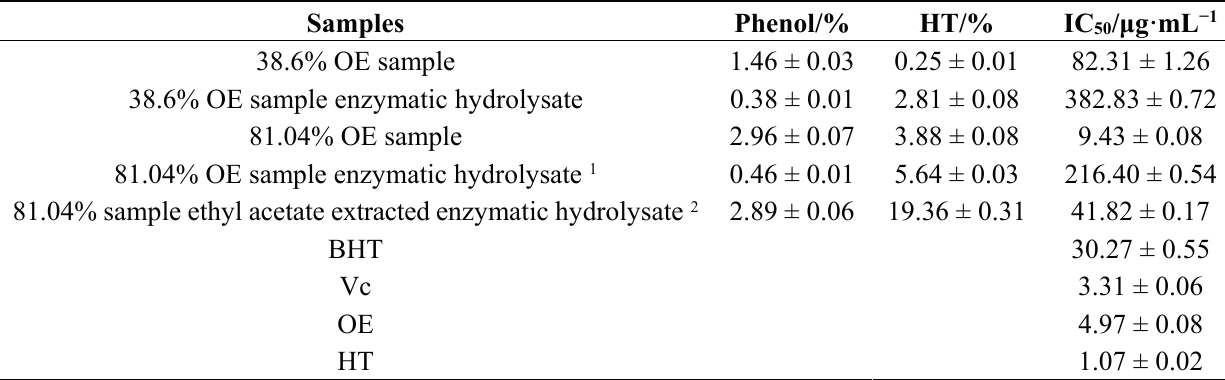
Table 4. Phenols content, hydroxytyrosol (HT) concentration and radical scavenging effect (mean value ± SD, n =